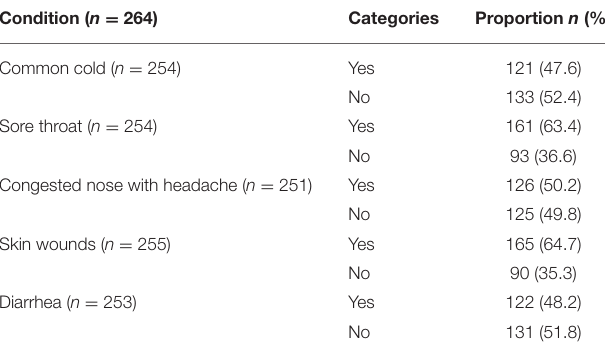
TABLE 5 | Practice or behavior toward antibiotic use among